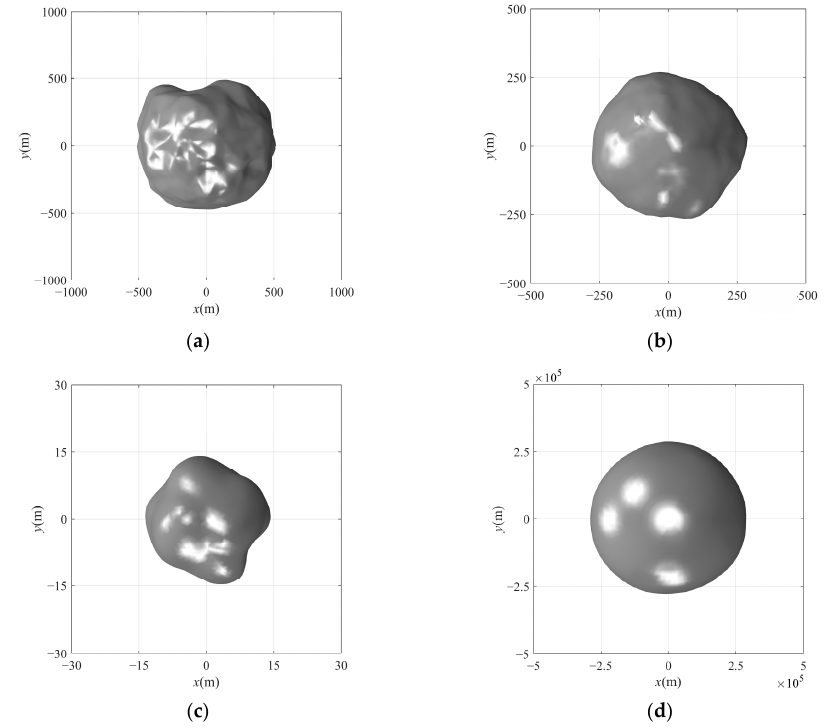
Figure 13. Polyhedral models corresponding to points 1–4 in Figure 12. ( a ) 52,760 (1998 ML 14 ). ( b ) 101,955 Bennu. ( c ) 1998 KY 26 . ( d ) 4 Vesta.